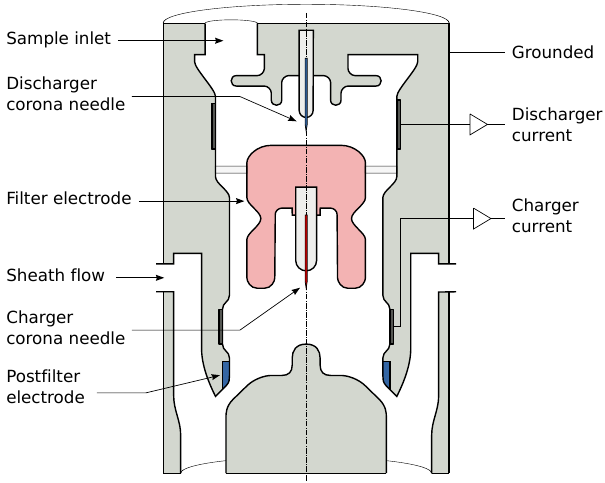
Fig. 2. Schematic of NAIS charger.